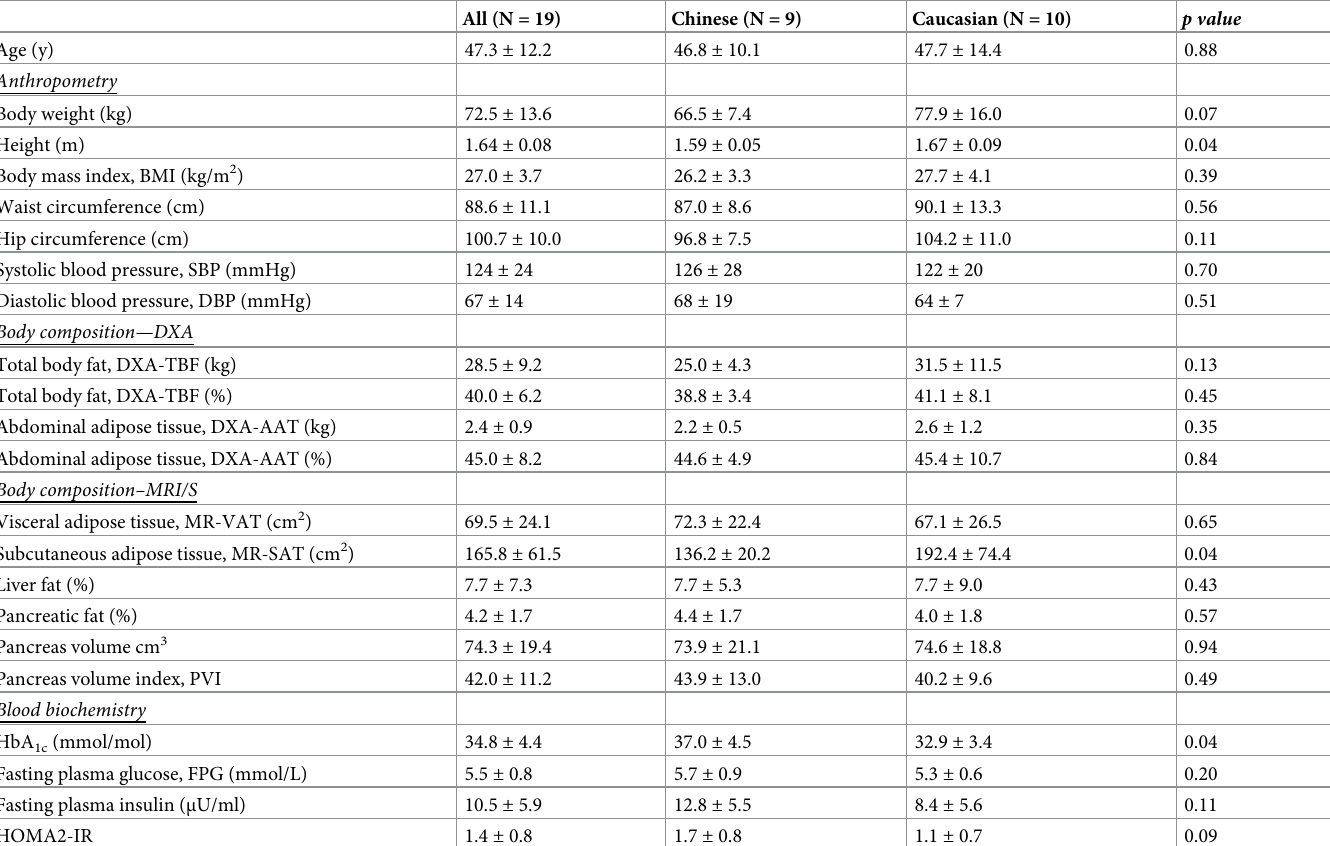
Table 1. Summary characteristics of baseline anthropometry and body composition variables, determined by dual-energy X-ray absorptiometry and magnetic reso- nance imaging, in Chinese and Caucasian women enrolled in the ivGTT